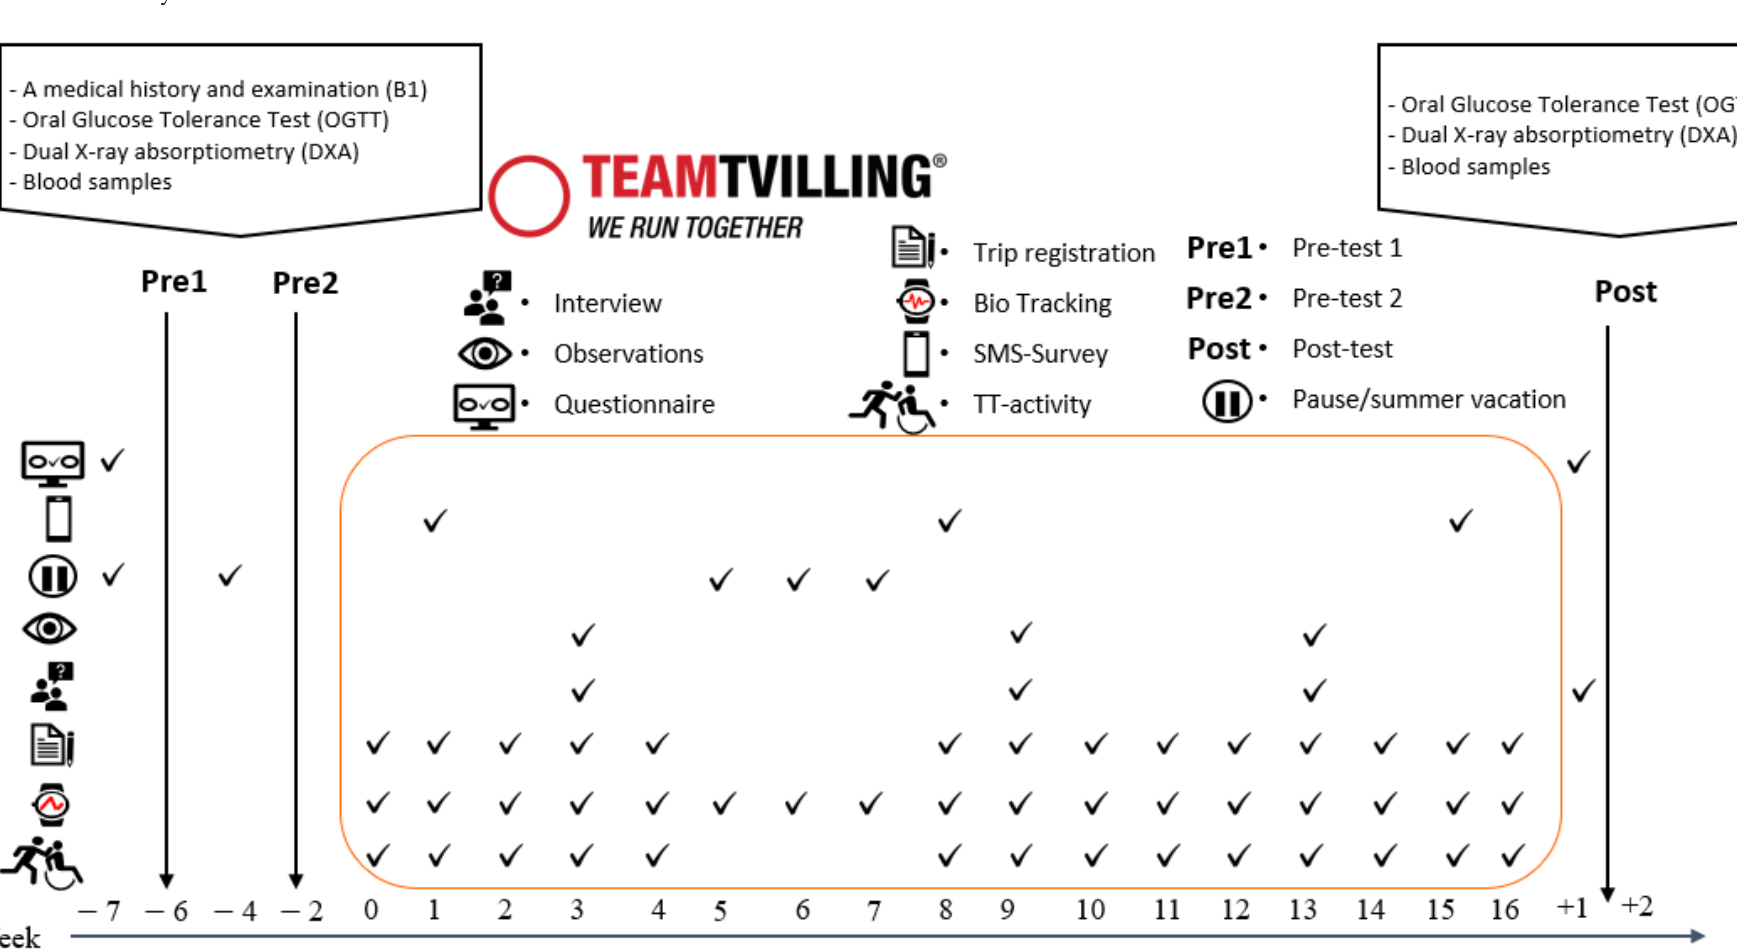
Figure 3. Overview of activities taking place during the TT subproject of WMM.